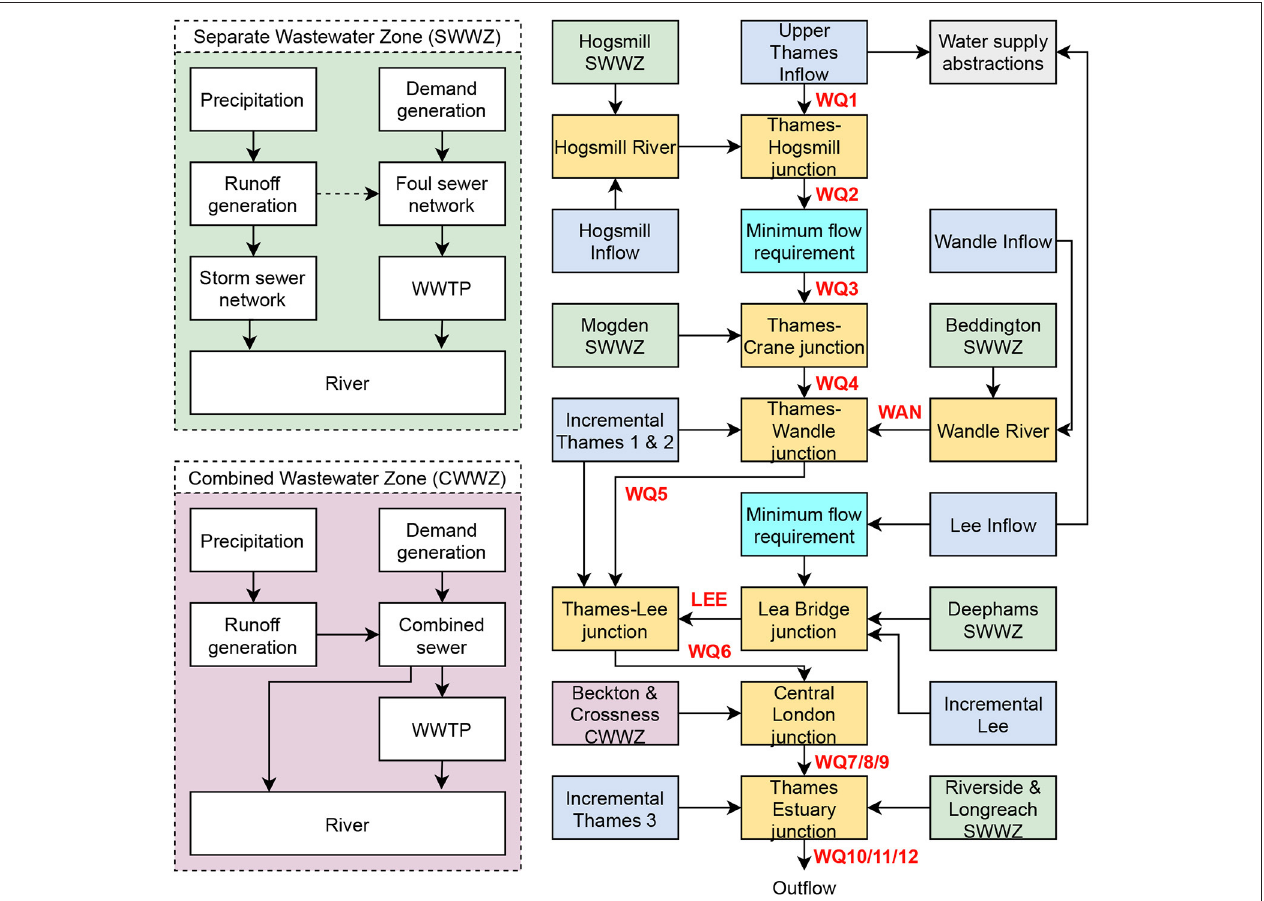
FIGURE 4 | Schematic depicting nodes of the London model. Green nodes are separate wastewater zones, blue nodes are model inflows, gray is the water supply abstractions, orange nodes are junctions, cyan nodes are minimum flow requirements and purple is the two combined wastewater zones. WWTP stands for wastewater treatment plant. The dashed arrow in the Separate Wastewater Zone box (top left) represents infiltration into the foul sewer network. Water quality sampling sites are indicated in bold red and can be matched with the sites in Figure 1